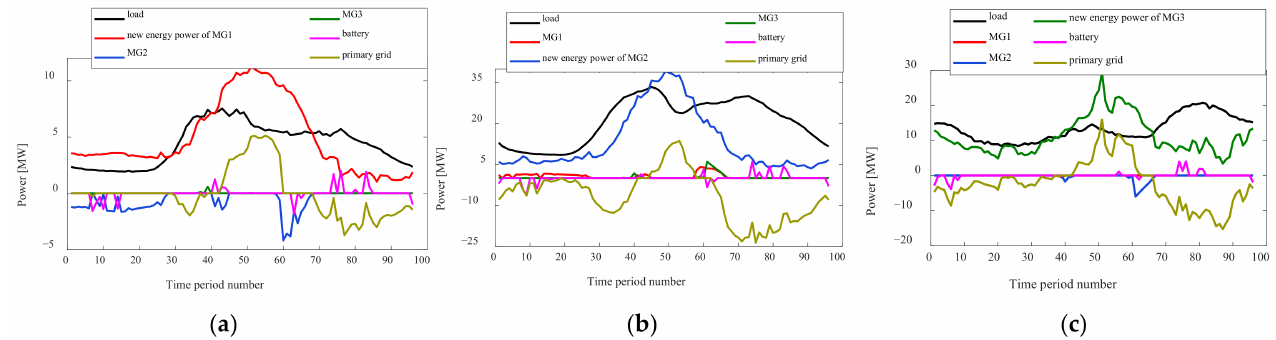
Figure 7. Power dispatching of multi-microgrid by CS algorithm and improved CS algorithm: ( a ) MG1; ( b ); MG2 ( c );